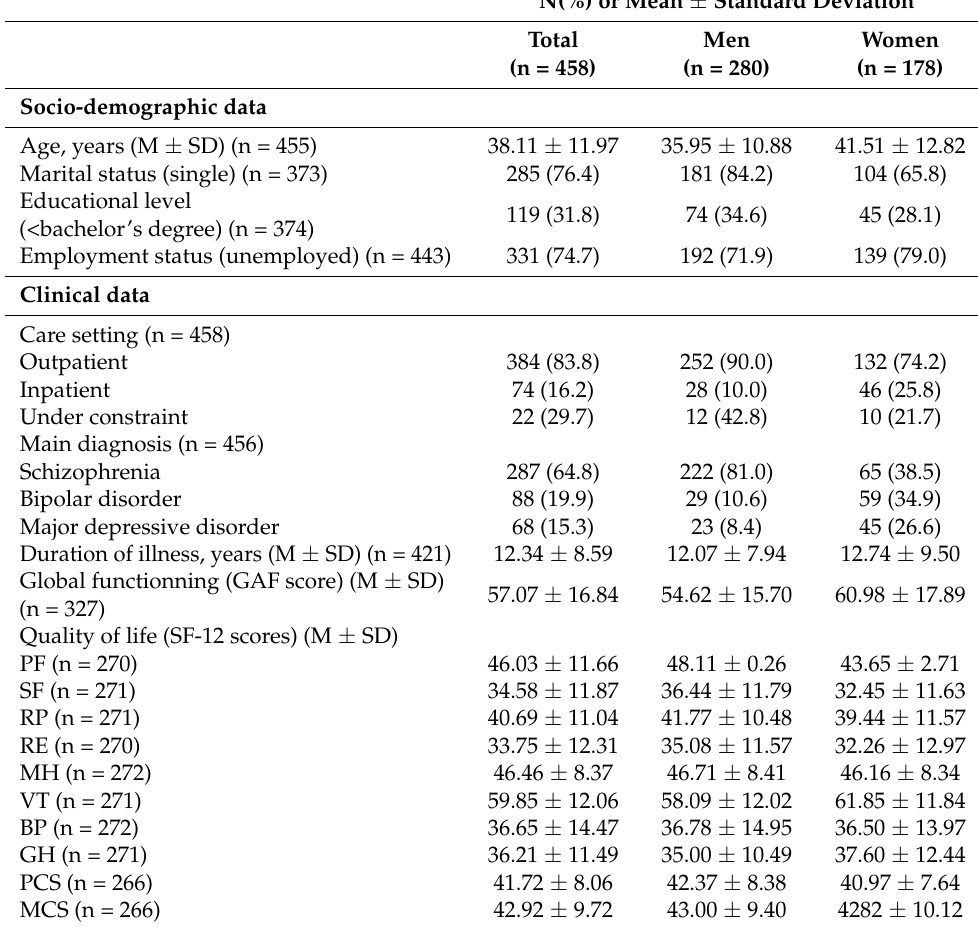
Table 1. Sample description.